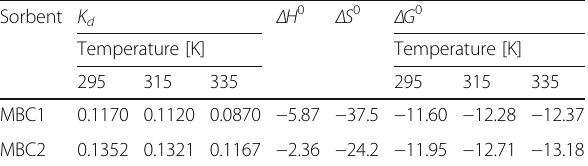
Table 5 Thermodynamic parameters for the sorption of Cd(II) ions on MBC1 and MBC2 Sorbent K